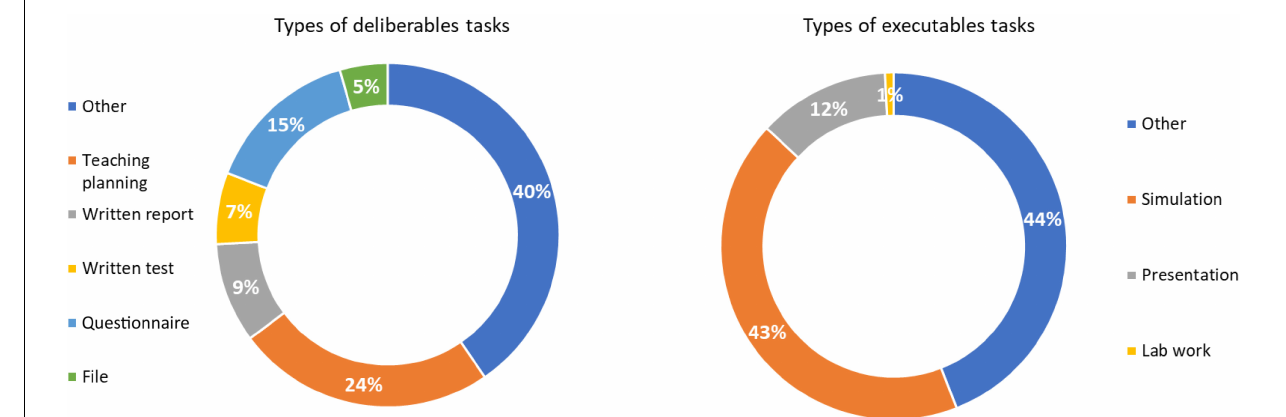
FIGURE 4 | Types of planned assessment deliverables and executables.